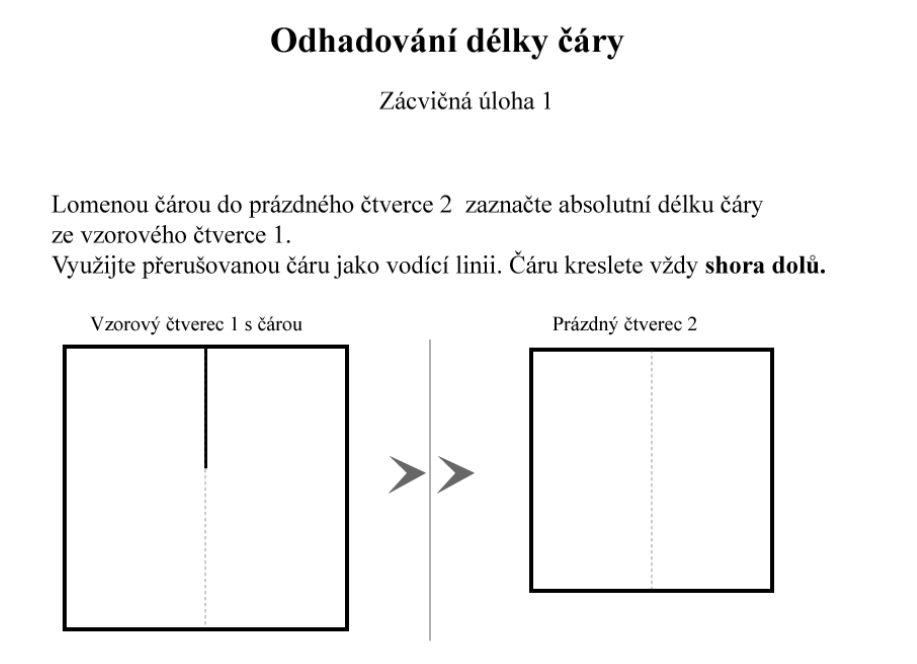
Fig. 9. Practice phase of Absolute-relative test, adapted version of FLT. [The evaluation of the Length of the